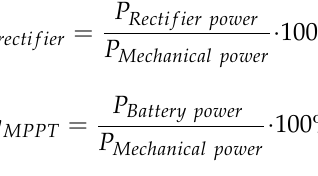
Table 2. Simulation result of power and efficiency using the proposed algorithm.